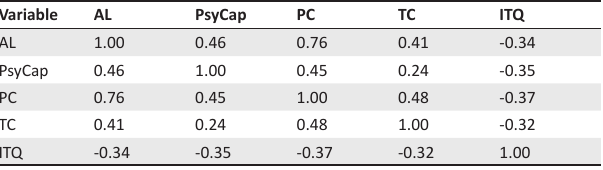
TABLE 3: Product–moment correlations between authentic leadership, psychological capital, psychological climate, team commitment and intention to quit ( N =